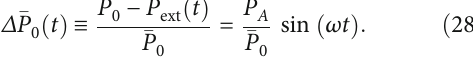
Figure 7: Viscoelastic-creep parametric study under step pressure; in fl uence of temperature, ϵ ( x -axis); parameter on relaxation time, τ ( y -axis); parameter at ϵ parameter ranges between 0.175 and c 0.200 with three di ff erent atomic density, j (cid:1) ρ numerical experiments are based on step pressure input (cid:1) ( Δ = 0 : 02 ). It should be noted that the ϵ parameter is inversely P 0 related to